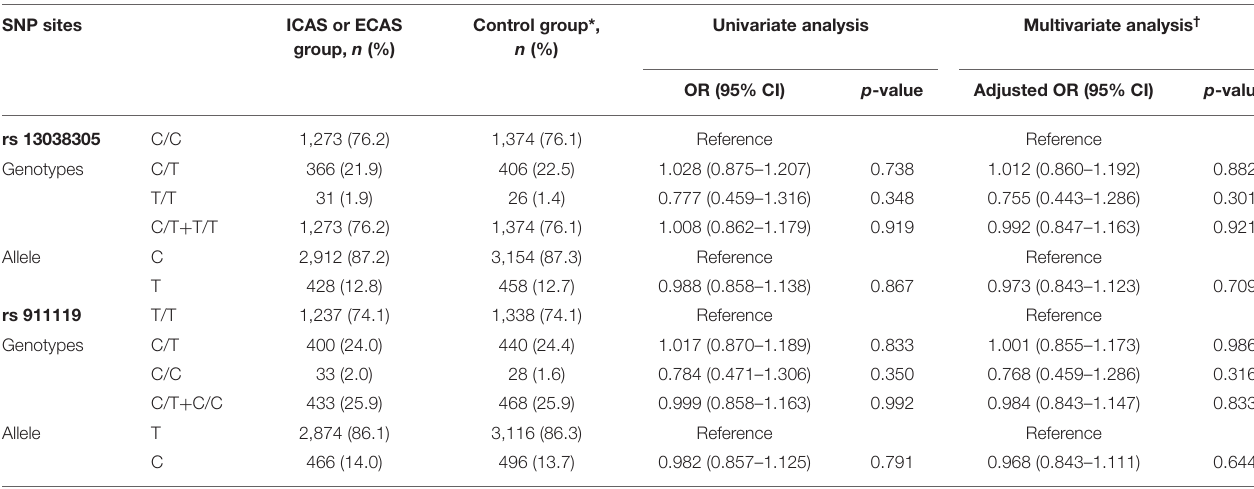
TABLE 3 | Genotype and allelic frequencies of CST3 SNPs in ICAS or ECAS group. SNP